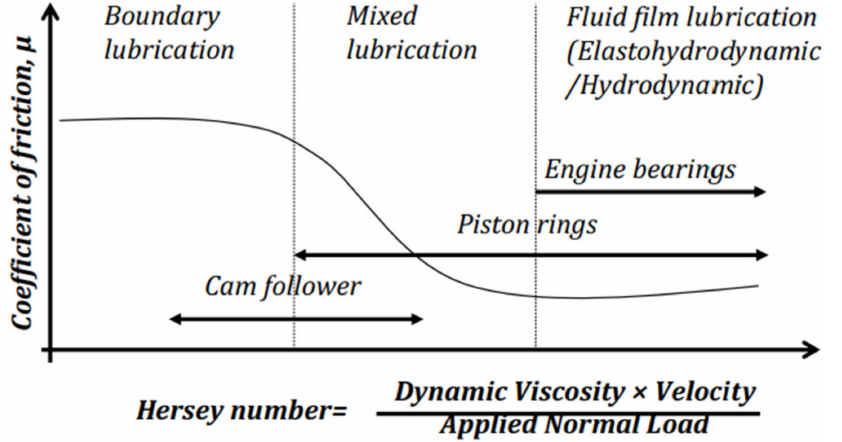
Figure 4. Stribeck curve showing engine components in various lubrication regimes [35].